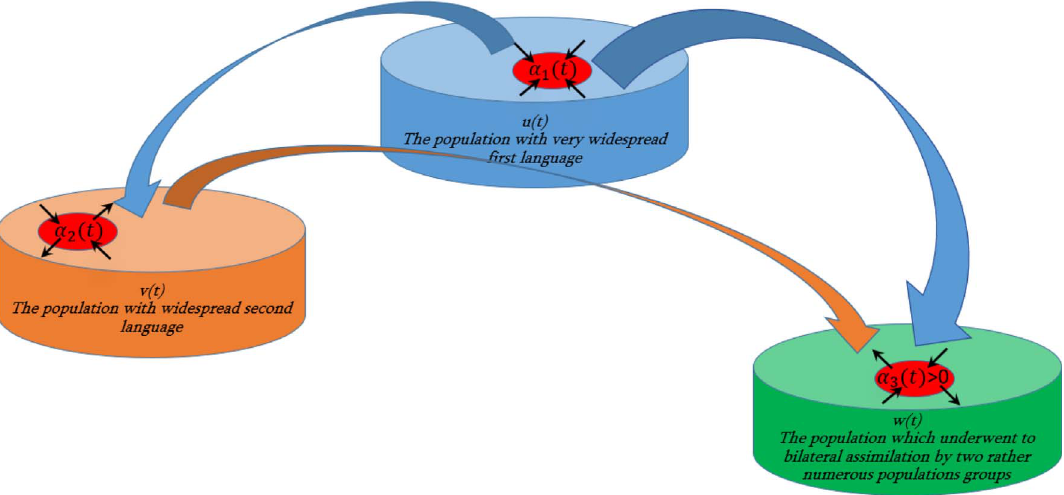
Figure 1. Development of two-level assimilation